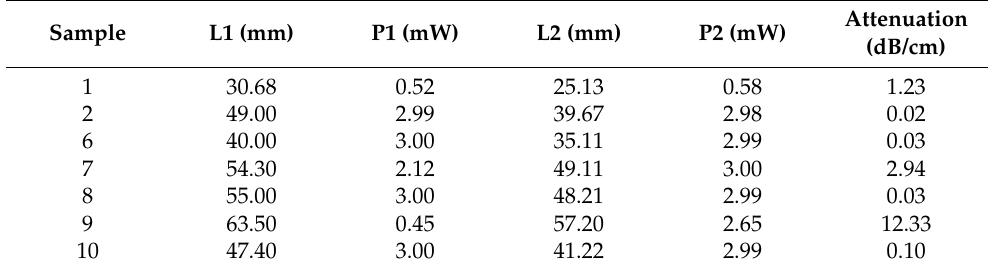
Table 5. Attenuation calculated to produced POFs. The attenuation was measured at 650 nm wavelength